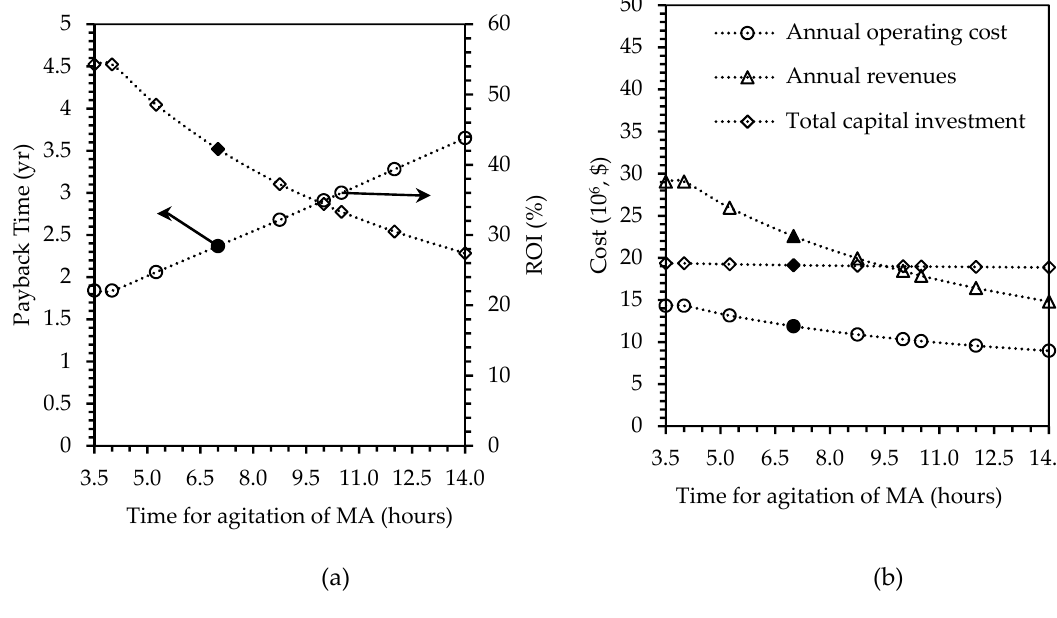
Figure 7. Effects of changing methacrylation agitation time, on ( a ) payback time in years and ROI in percent, and ( b ) annual operating cost, annual revenues, and total capital investment in U.S. dollars. Filled markers represent results of the base case scenario.